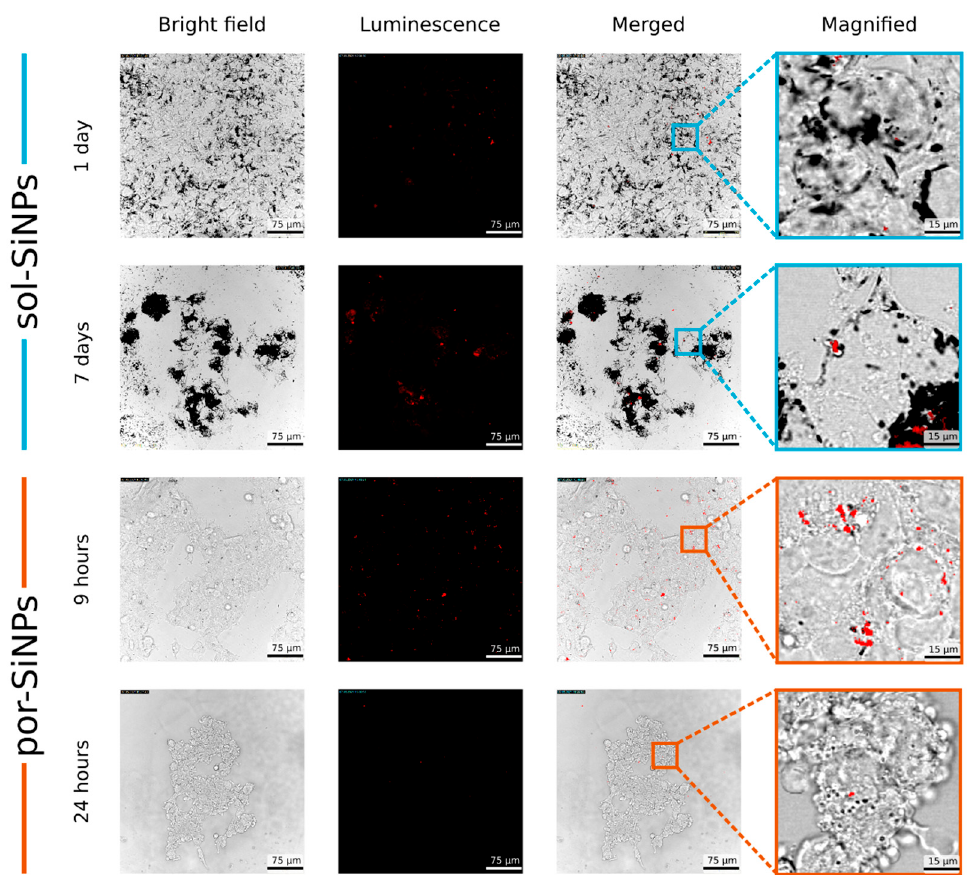
Figure 6. Widefield and luminescent confocal bioimaging of SiNPs inside human cells (HEK293T). Columns (from left to right): widefield view of cells; luminescence; merged images; magnification of the merged images. Rows: sol-SiNPs after 1 and 7 days of incubation, and por-SiNPs after 9 and 24 h of incubation.